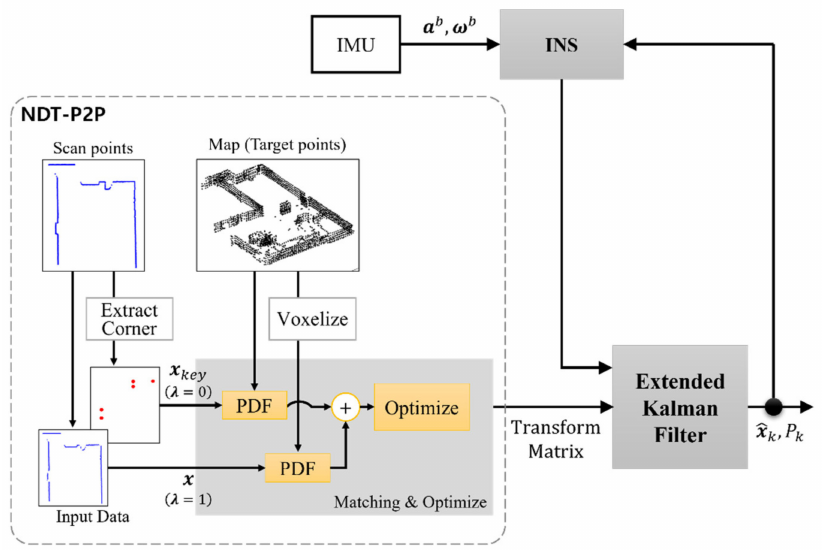
Figure 5. The block diagram of INS integration with